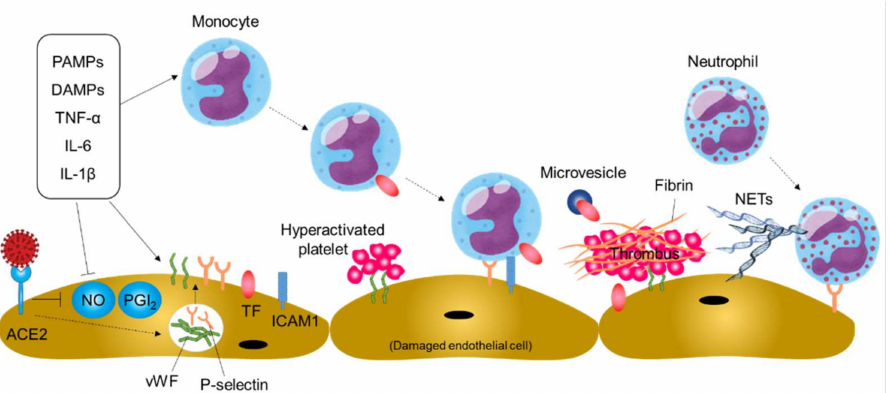
Figure 4. Thromboinflammation and endothelial dysfunction in COVID-19. Systemic inflammation and direct SARS-CoV-2 infection of endothelial cells may cause thromboinflammation, leading to thromboembolic events in patients with COVID-19. PAMPs, pathogen-associated molecular patterns; DAMPs, damage-associated molecular patterns; ACE2, angiotensin-converting enzyme 2; NO, nitric oxide; PGI 2 , prostaglandin I 2 ; vWF, von Willebrand factor; TF, tissue factor; ICAM1, intercellular adhesion molecule-1; NETs, neutrophil extracellular